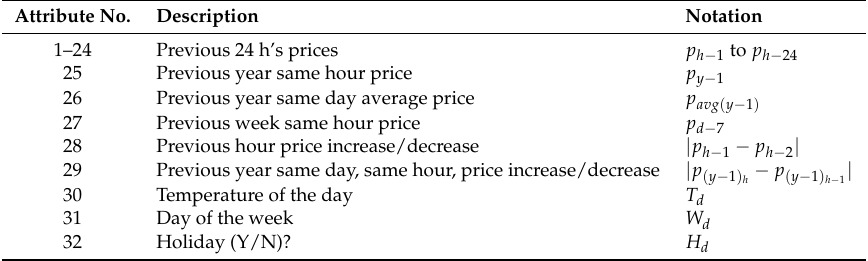
Table 1. Selected features for the NYISO (New York Independent System Operator)